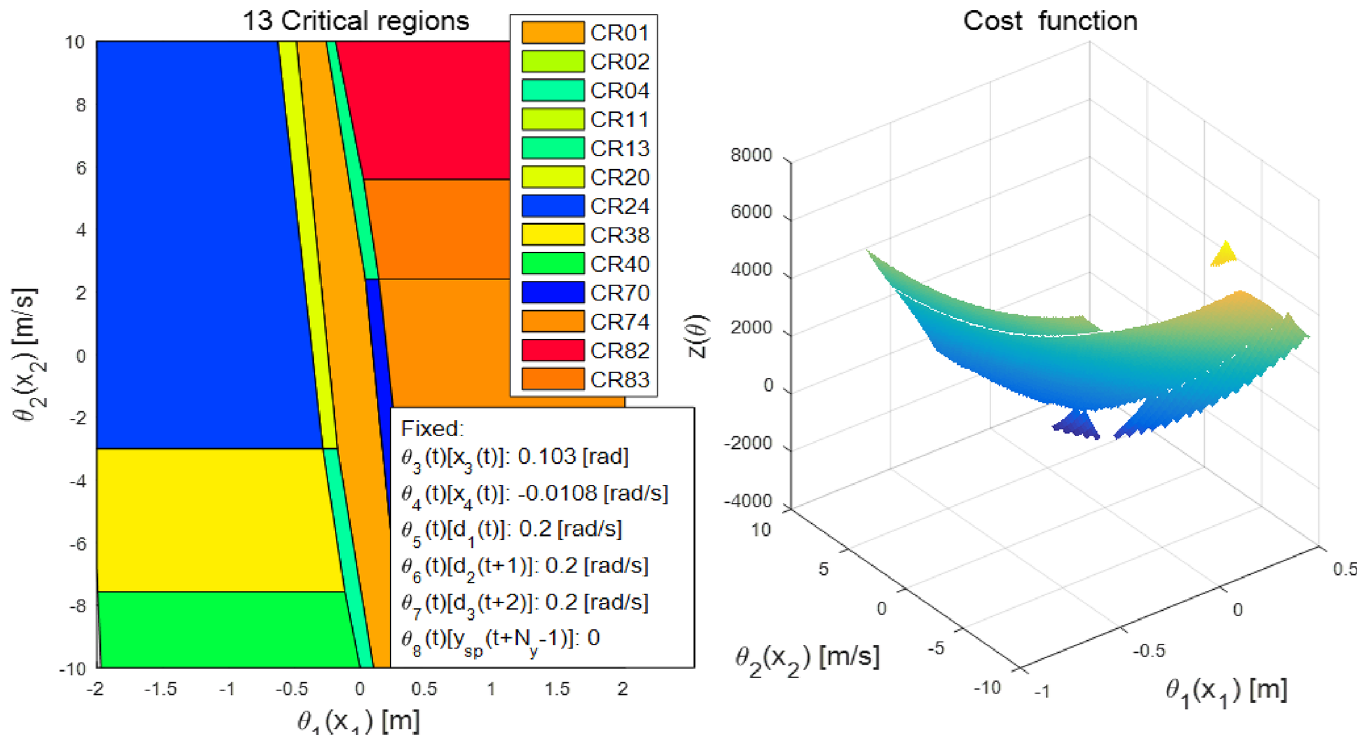
Fig 3. Critical regions. An example of critical regions and the associated cost function are illustrated in this figure. In this figure, y ð t Þ ≜ ½ x ð t Þ ; u ð t Þ ; u ð t þ 1 Þ ; u ð t þ 2 Þ ; y ð t þ N (cid:0) 1 Þ(cid:138) , where x ( t ), u 2 ( t ), and y 2 2 2 sp y within the prediction horizon N y , respectively. The proposed controller predicts the second input, which can be obtained from the desired path, along N y .